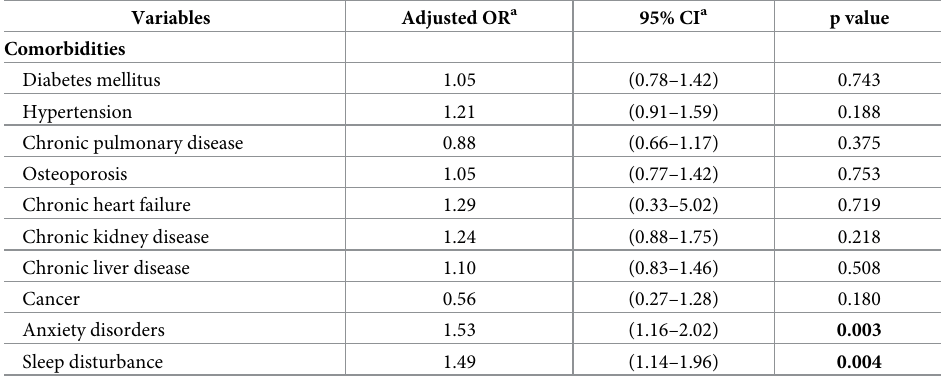
Table 2. Risk factors for depression in the study patients with Parkinson’s disease (n =